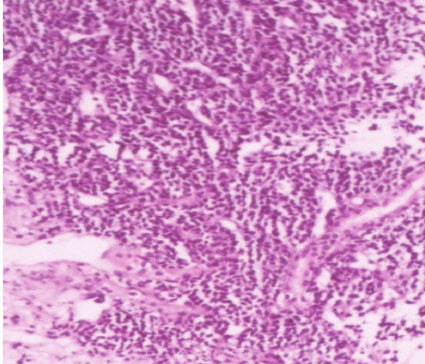
Figure 2: Low power view shows round to spindle cells with hemangiopericytomapatternwithareasofhyalinizationinbetween.